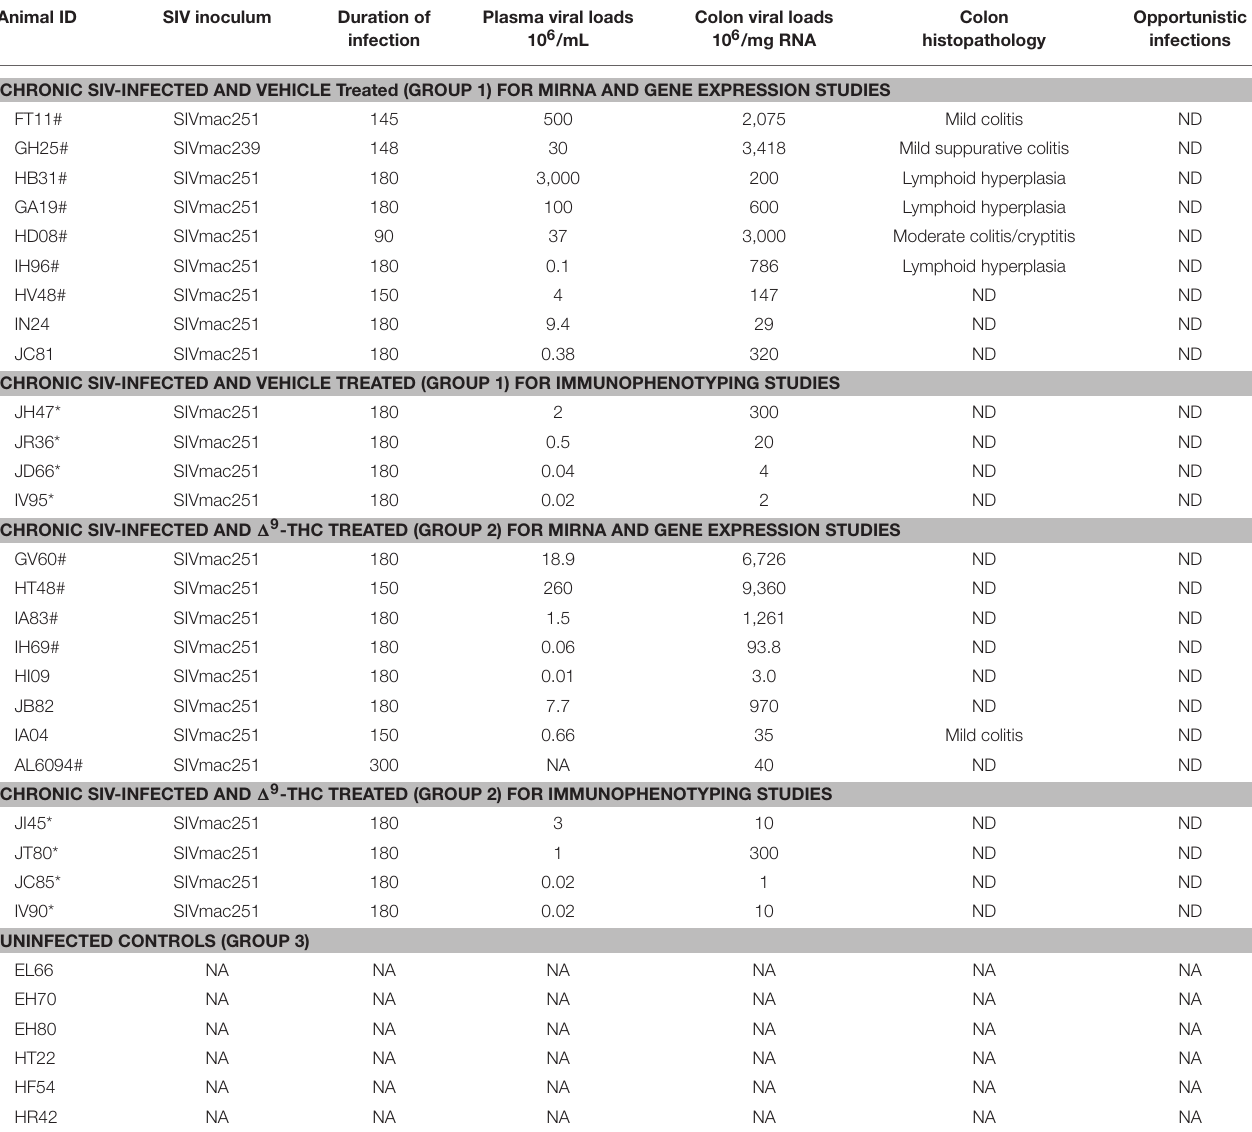
TABLE 1 | Animal IDs, SIV inoculum, duration of infection, viral loads and colon histopathology in vehicle or delta-9-tetrahydrocannabinol ( 1 9 -THC) treated chronic SIV-infected and uninfected rhesus macaques. Animal ID SIV